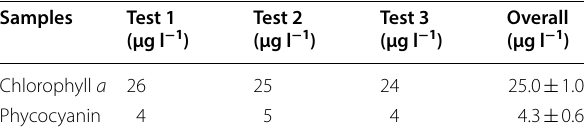
Table 1 The results of chlorophyll a and phycocyanin pigments estimated by measuring samples that are collected from the local lake